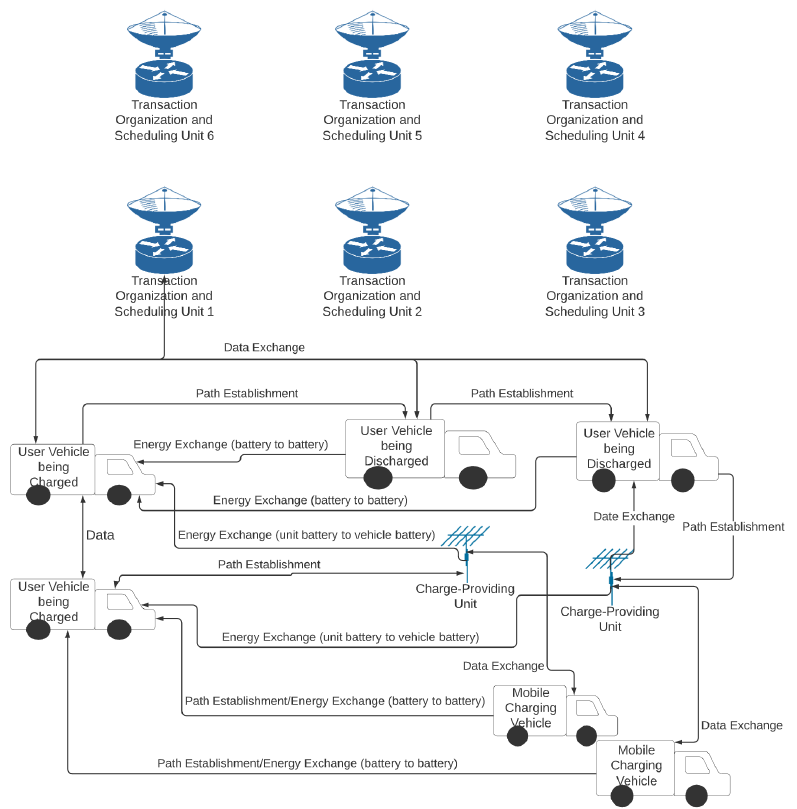
Figure 22. A diagram presenting the overall layout of the hybrid-based vehicle system, inspired by